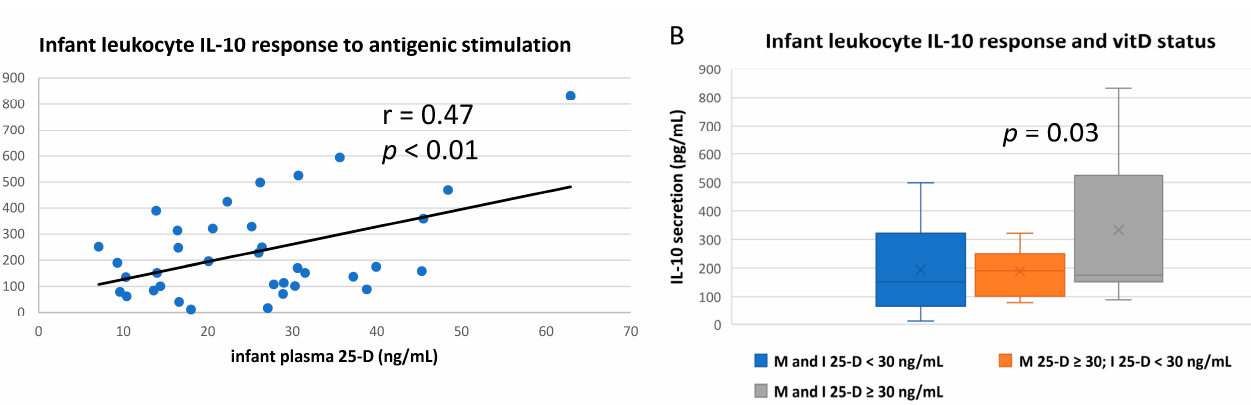
Figure 7. IL-12 responses of infant leukocytes to in vitro antigenic stimulation. Whole blood from breastfeeding infants was antigen-stimulated and culture supernatants analyzed for IL-12 content. Cytokine release after stimulation correlated to ( A ) infant’s own plasma 25-D or ( B ) maternal plasma 25-D. ( C ) Mean infant IL-12 responses after antigenic stimulation compared between groups based on both infant (I) and maternal (M) vitD sufficiency (plasma 25-D ≥ 30 ng/mL) at the corresponding time of blood draw.